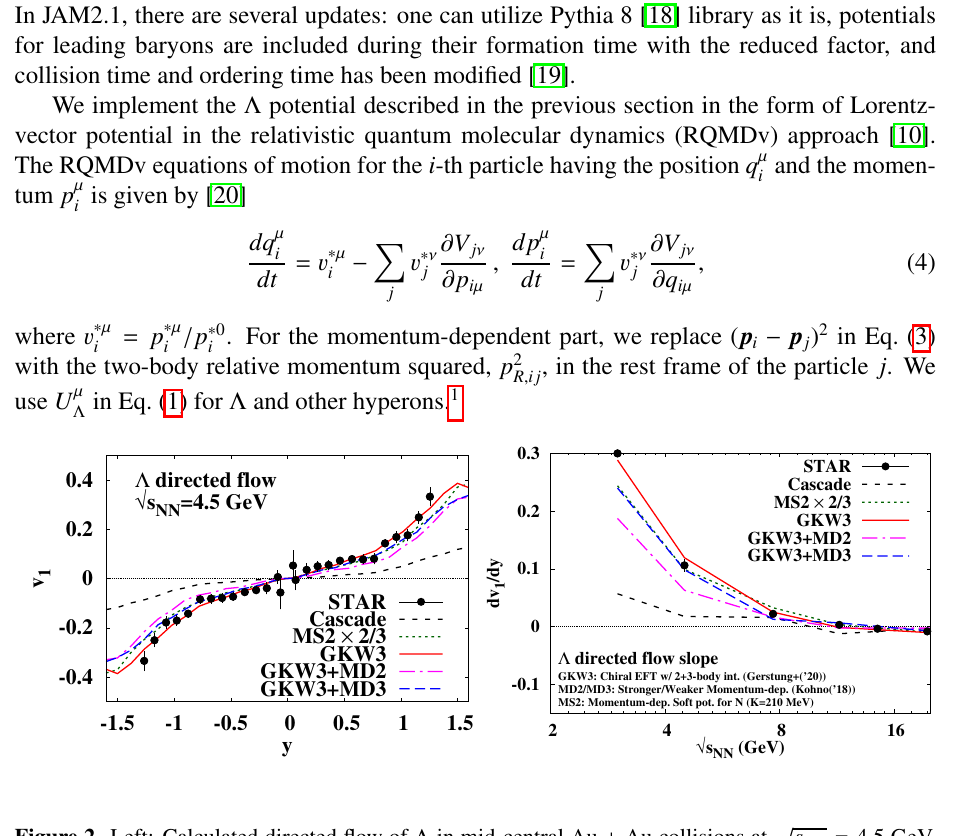
potentials: GKW2 fit (thin solid, without momentum dependent terms) and GKW2 + MD1 (dashed), and GKW3 fit (thick solid) and GKW3 + MD2 / MD3 (dash-dotted, long dashed) at ρ/ρ 0 ≤ 3.